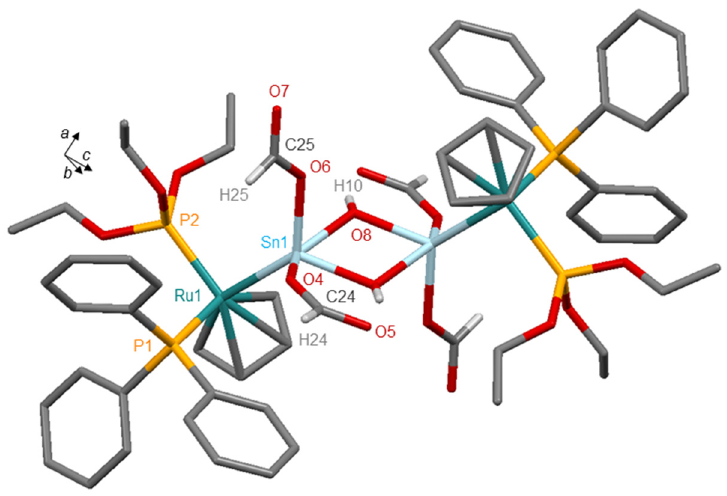
Figure 13. Molecular structure of 10 , adapted from [64] (MERCURY view). Hydrogen atoms are omitted for clarity except those of hydroxyl and formate groups (Ru blue green, Sn light blue, O red, P orange, C grey, H white).